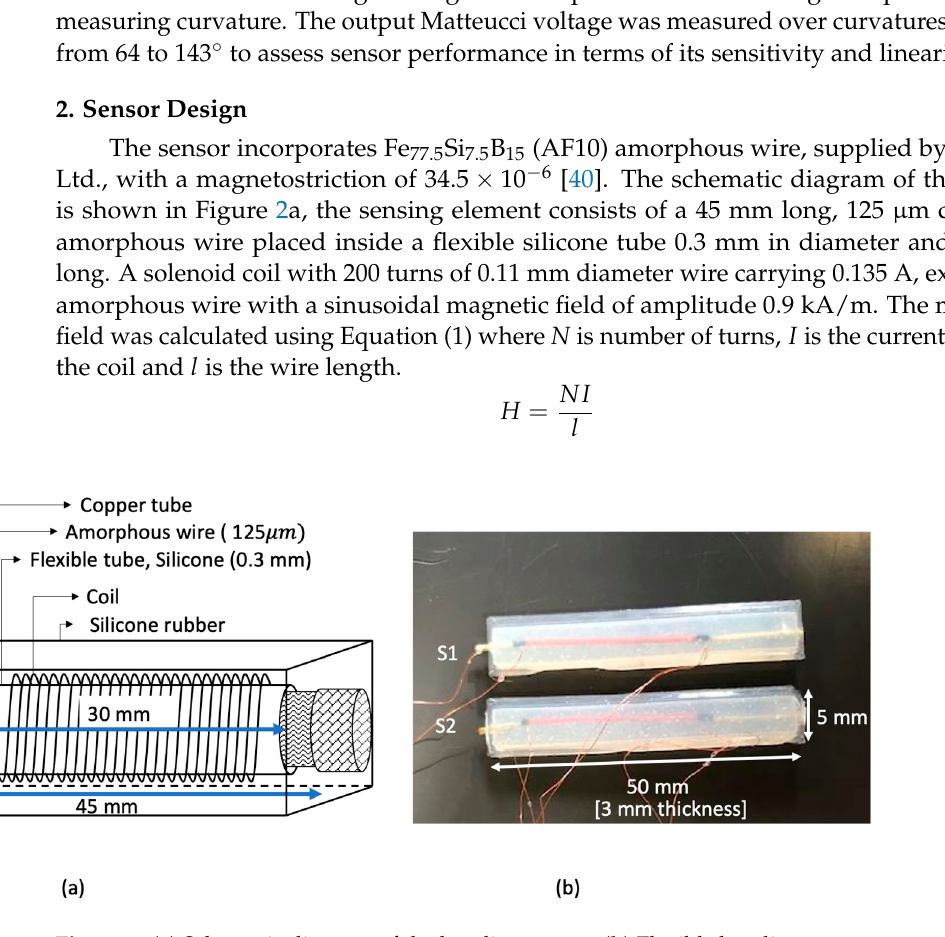
Figure 2. ( a ) Schematic diagram of the bending sensor. ( b ) Flexible bending sensors. Copper wires were connected across the ends of the amorphous wire to pick up the Matteucci